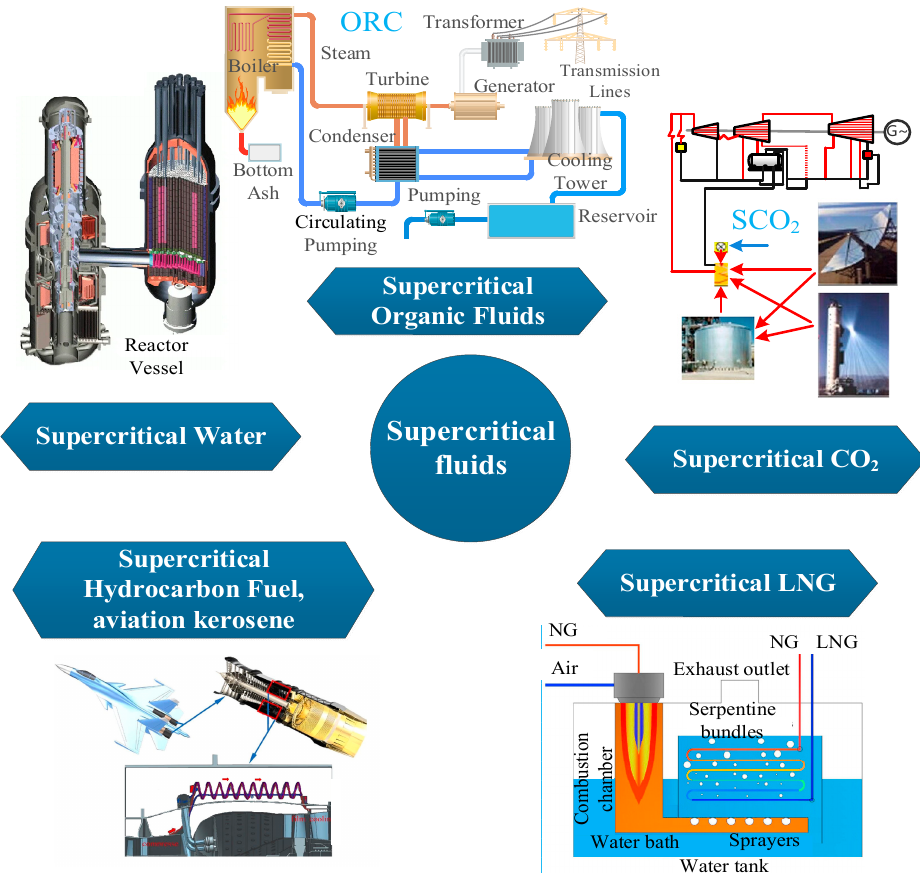
Figure 2. Examples of applications of supercritical fluids in various fields.